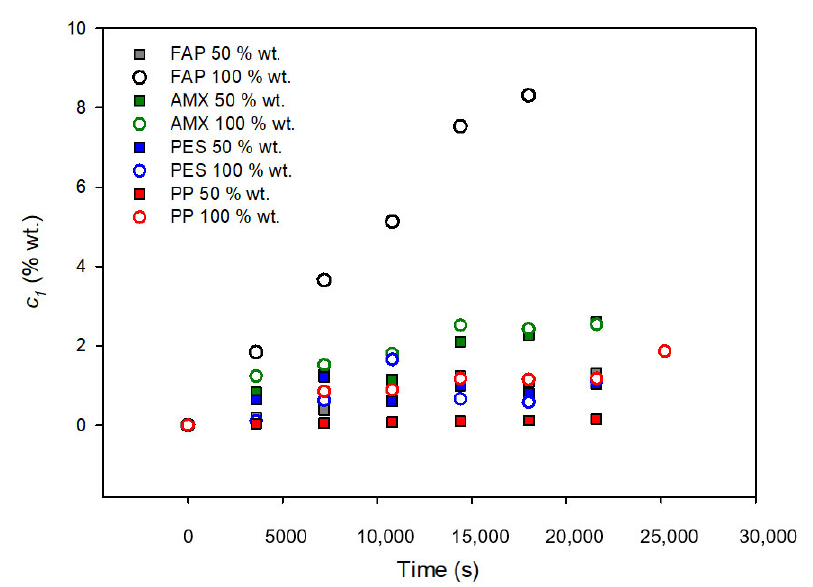
Figure 2. Concentration as a function of time in the water chamber with non-doped membranes with pure methanol and 50% wt. water–methanol mixture in the alcohol chamber.